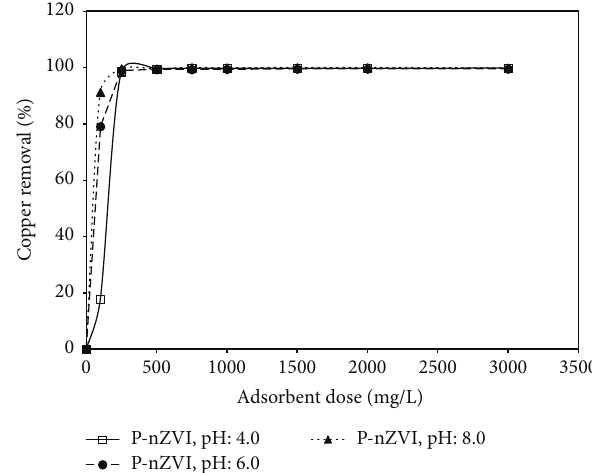
Figure 6: The effect of solution pH on copper removal (equilib- rium time: 4h; temperature: 20 ∘ C, 150 rpm; copper concentration: 3000